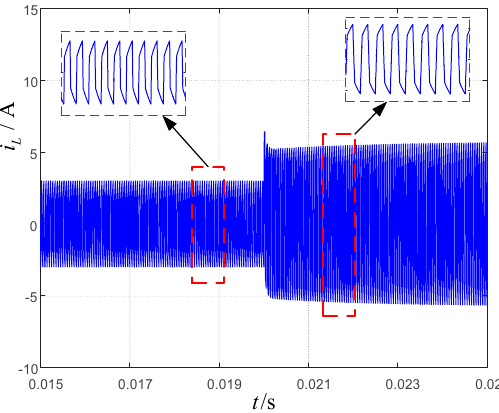
ff erent load resistance.